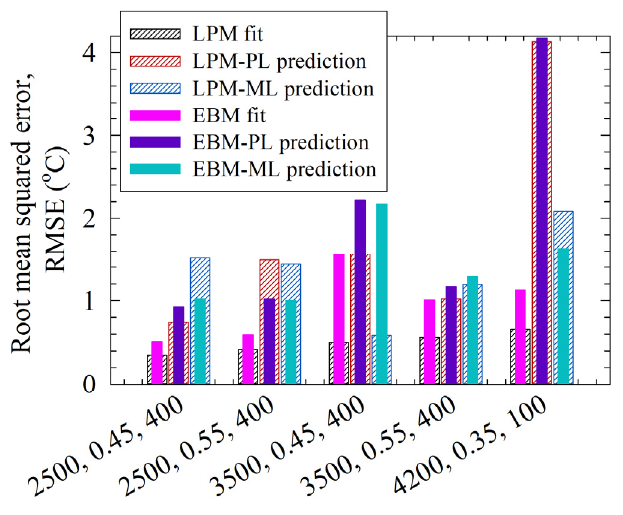
Figure 8. Comparison of the root-mean-squared errors of the direct fits and the predictions made by the power law (PL) and machine learning (ML) models coupled with the lumped parameter model (LPM) and the enthalpy balance model (EBM). The EBM predictions were taken from Guner et al. (2022) [33] .